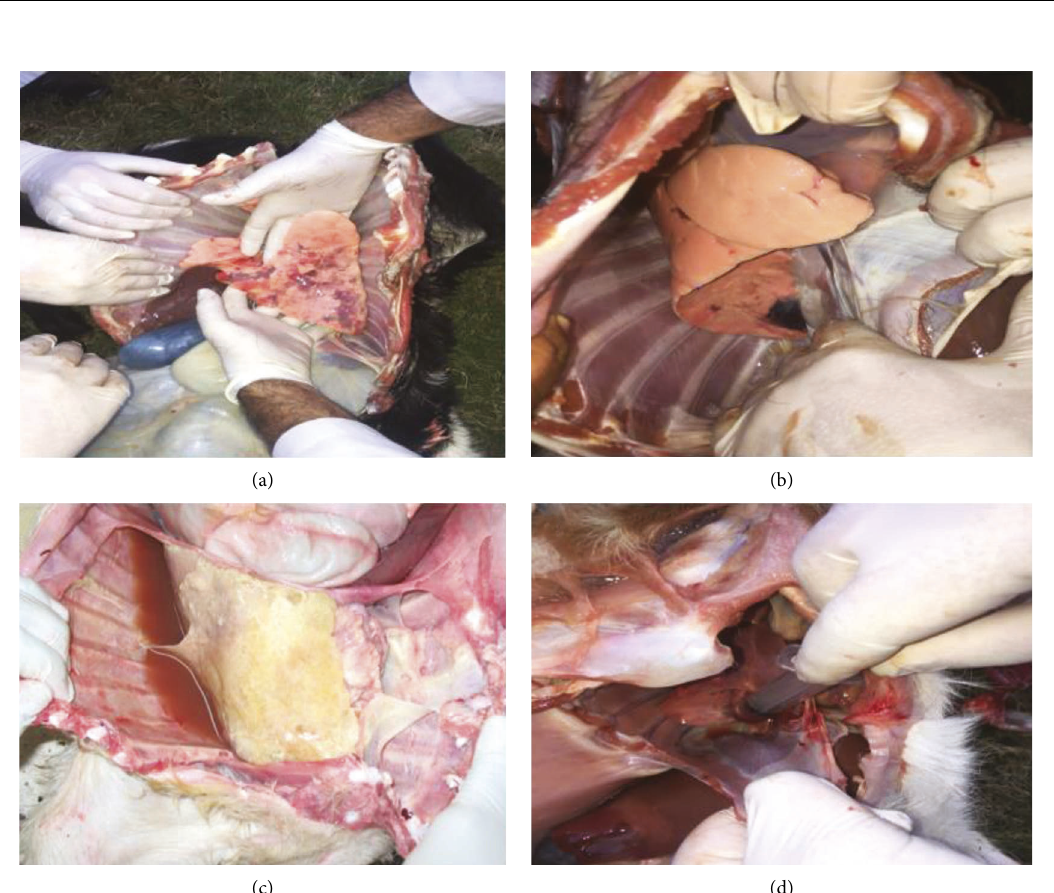
Figure 6: (a) Gross lesion in the lungs of a goat at post mortem examination suffering from respiratory symptoms suspected for Mccp. The lungs showing red hepatization, accumulation of pleural fluid, and haemorrhages (b). Gross lesion in lungs of a goat at post mortem examination suffering from the respiratory symptom suspected for Mccp. The lungs showing consolidation and accumulation of pleural fluid (c). Gross lesion in the lungs of a goat at post mortem examination suffering from the respiratory symptom suspected for Mccp. Accumulation of pleural fluid in pleural cavity (d). Gross lesion in the lungs of a goat at post mortem examination suffering from the respiratory symptom suspected for Mccp. The lungs showing consolidation and accumulation of pleural fluid collected with a sterile